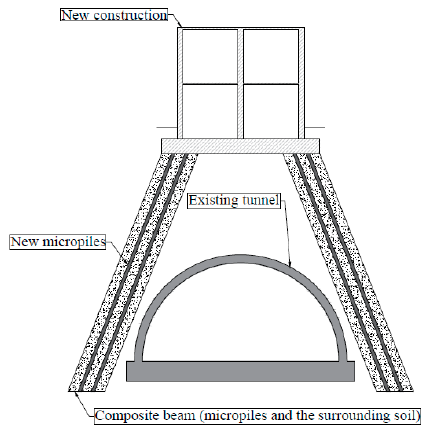
Figure 2. MPs used for a new foundation (after [3]).